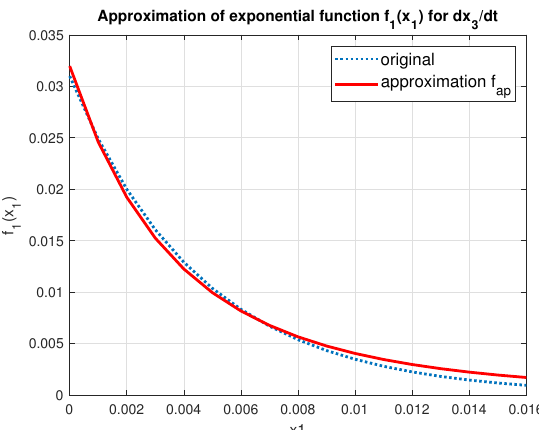
Figure 3. Quadratic rational function approximation of exponential term for dx 3